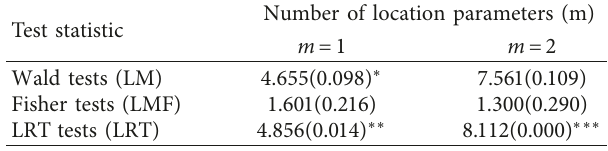
Table 7: Linear test result. Table 5: Variance inflation coefficient table of Taiwan’s entire